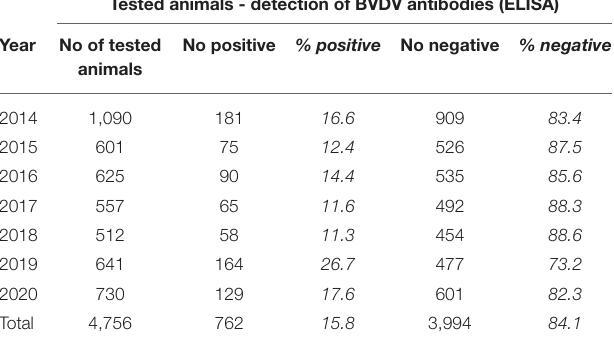
TABLE 1 | Results of tested animals by ELISA for detection of antibodies within voluntary BVDV control programme in Slovenia (2014–2020). Tested animals - detection of BVDV antibodies (ELISA) Year No of tested